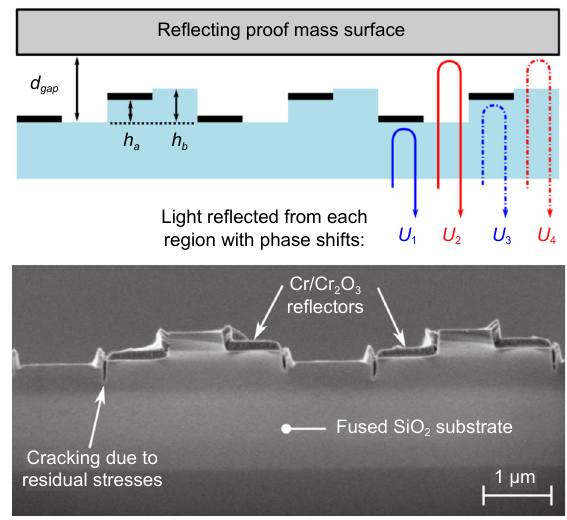
Fig. 10 | A modified phase-modulated grating. Figure reproduced with permission from ref. 32 , AIP